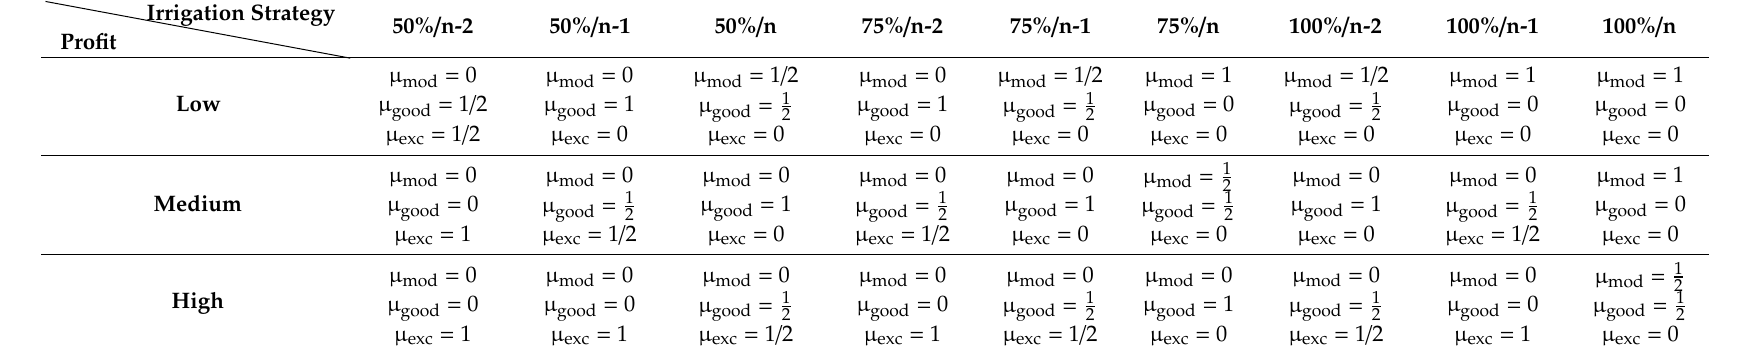
Table 12. Fuzzy membership values and